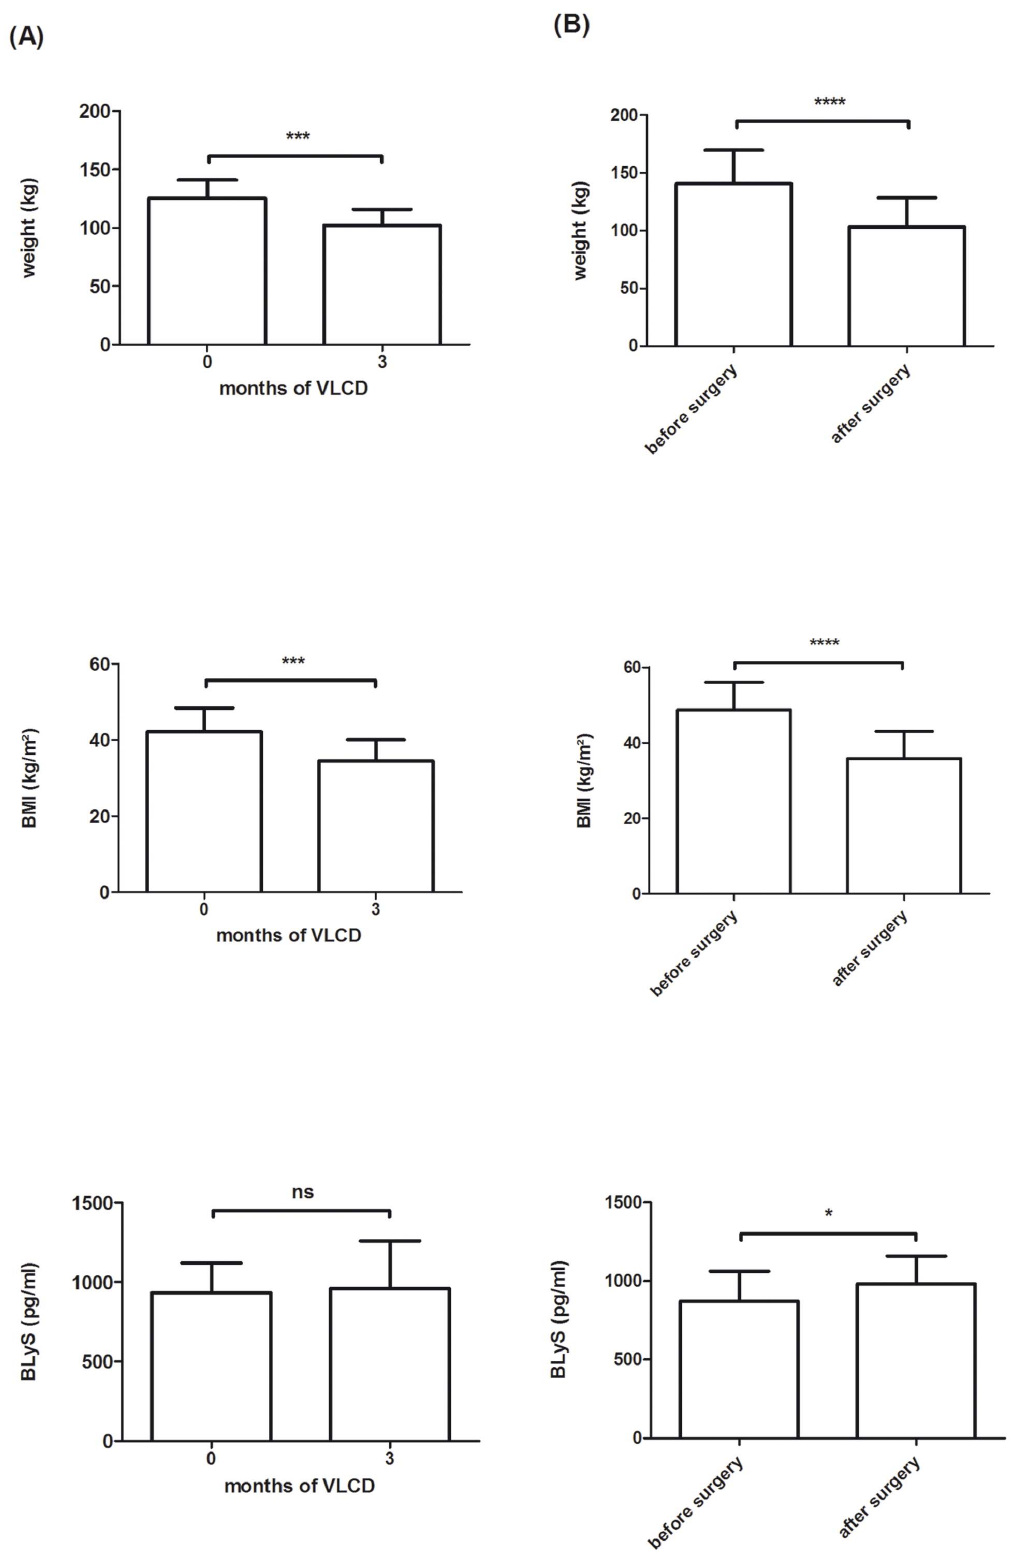
Figure 4. Anthropometric measures and BLyS serum concentrations before and after (3 months) of a very low calorie formula diet (VLCD) (approximately 800 kcal/d) as well as before and after (6 months) bariatric surgery in obese individuals. (A) Significant weight reduction (upper and middle panel) and no change of BLyS serum levels by VLCD (lower panel). Data in this figure are shown as means + SD of n=16 obese human subjects during a VLCD. (B) Significant weight reduction (upper and middle panel) and significant increase of BLyS serum levels by